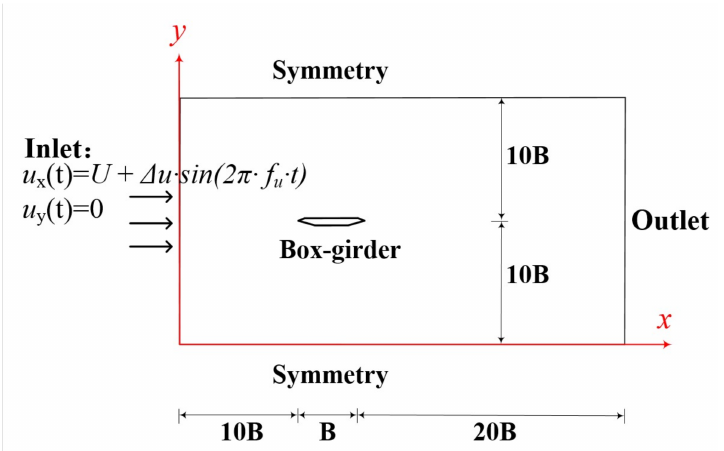
Figure 2. Computational domain and boundary conditions of the sinusoidal flow field.